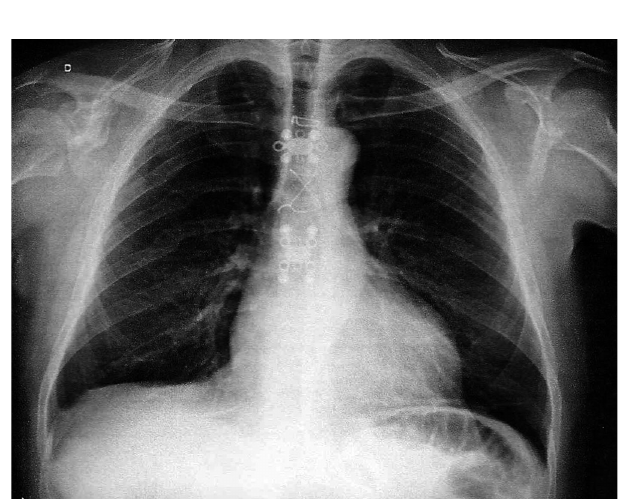
sixth month postoperatively, clinically and with chest